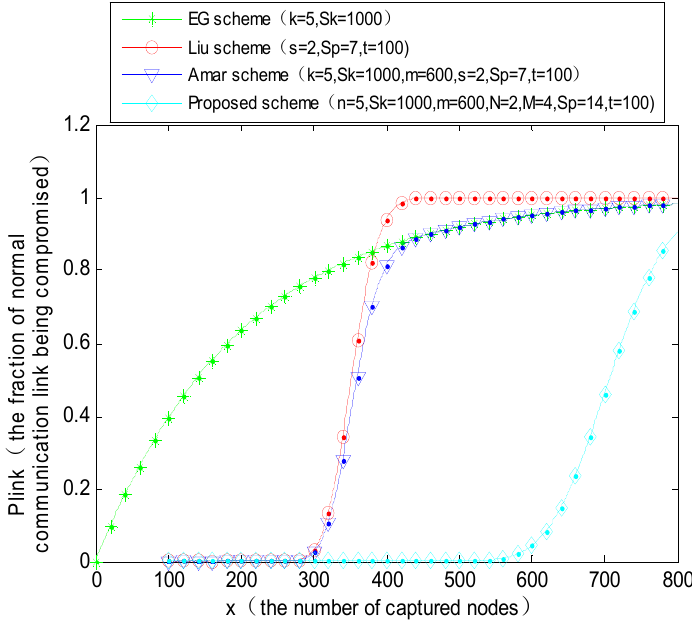
Figure 10. The probability that a normal communication link is captured when the direct connectivity p = 0.5.